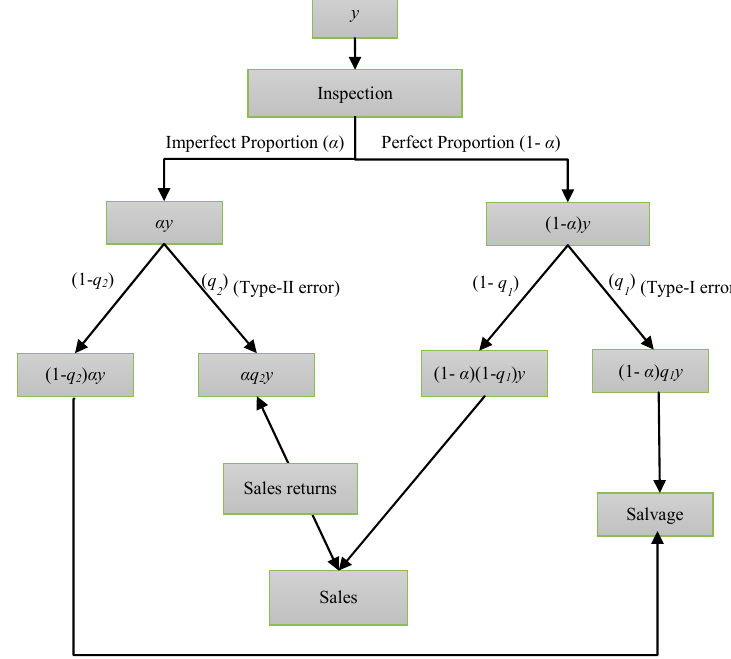
Figure 3. Flowchart of events in the inventory cycle.